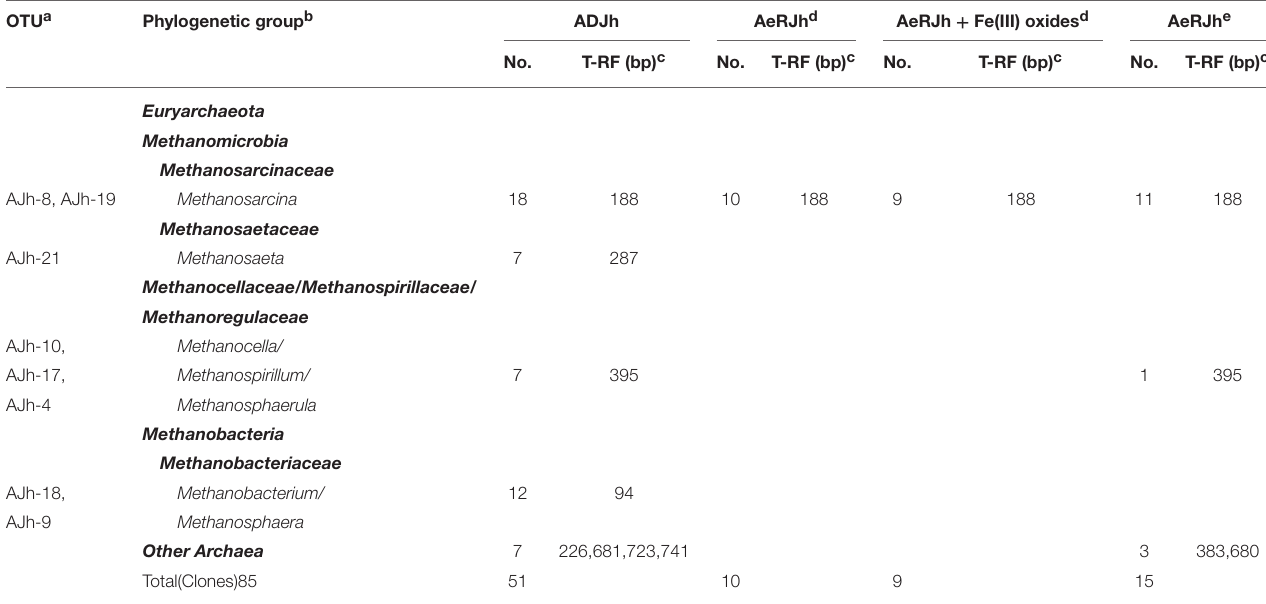
a An OTU consist of sequences exhibiting ≥ 97% sequence identity using Mothur software. b Based on BLAST tool (http://greengenes.lbl.gov). c Terminal restriction fragment (T-RFs) length were shown in base pairs (bp, TaqI) for different clones. d Represented a clone library of enrichment culture with acetate. e Represented a clone library of enrichment culture with ethanol. Bold: at family-level or